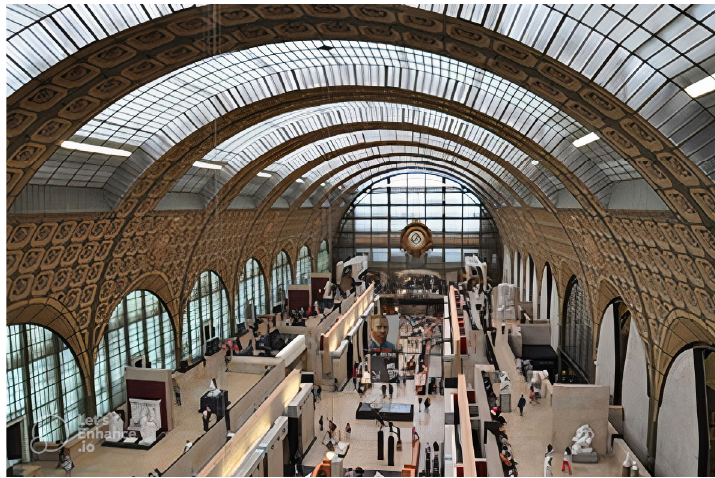
Figure 9. Orsay station. Source: Izhar Laufer. Flickr. Licence C.C. by Nc ‐ ND